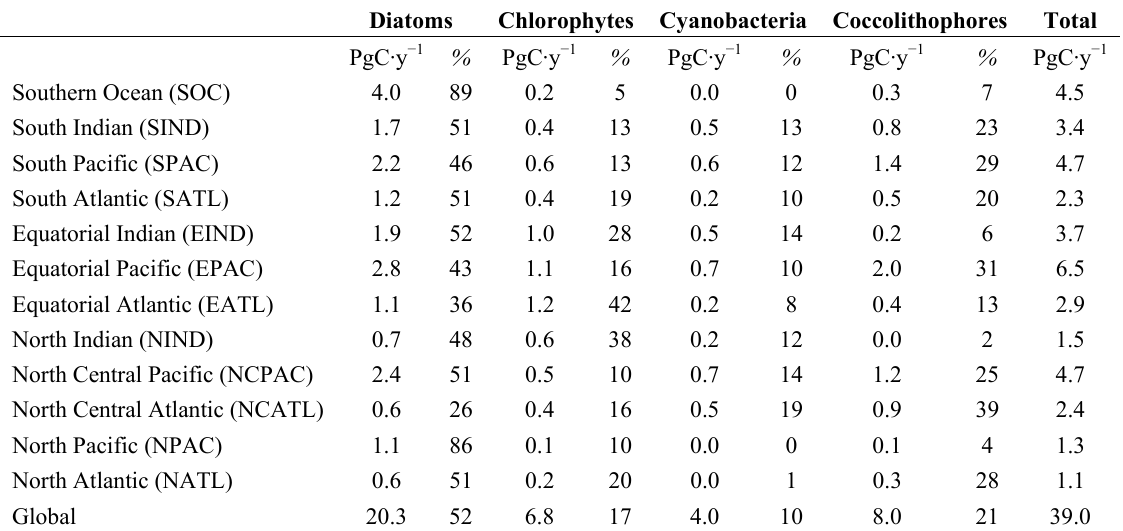
Table 1. Climatological primary production for the four phytoplankton groups in NOBM for 1998–2011, including relative contributions and total primary production.